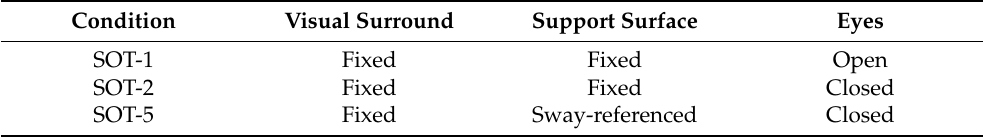
Table 1. Visual surround and support surface conditions for the Sensory Organization Test (SOT). Sway-referencing involves an anterior/posterior rotation of the platform and/or visual surround that occurs as a response to the person’s shifts in center of